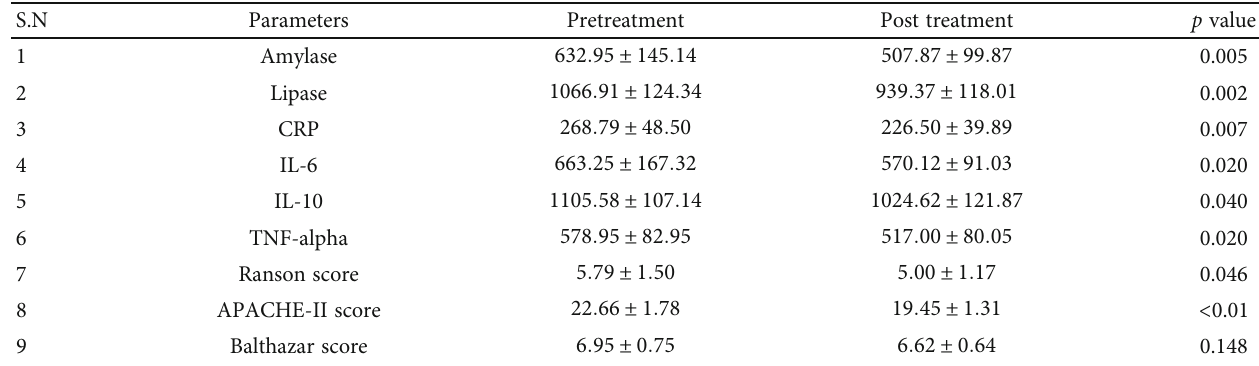
Table 3: Comparing di ff erent parameters in the conventional treatment group pre- and post treatment. S.N